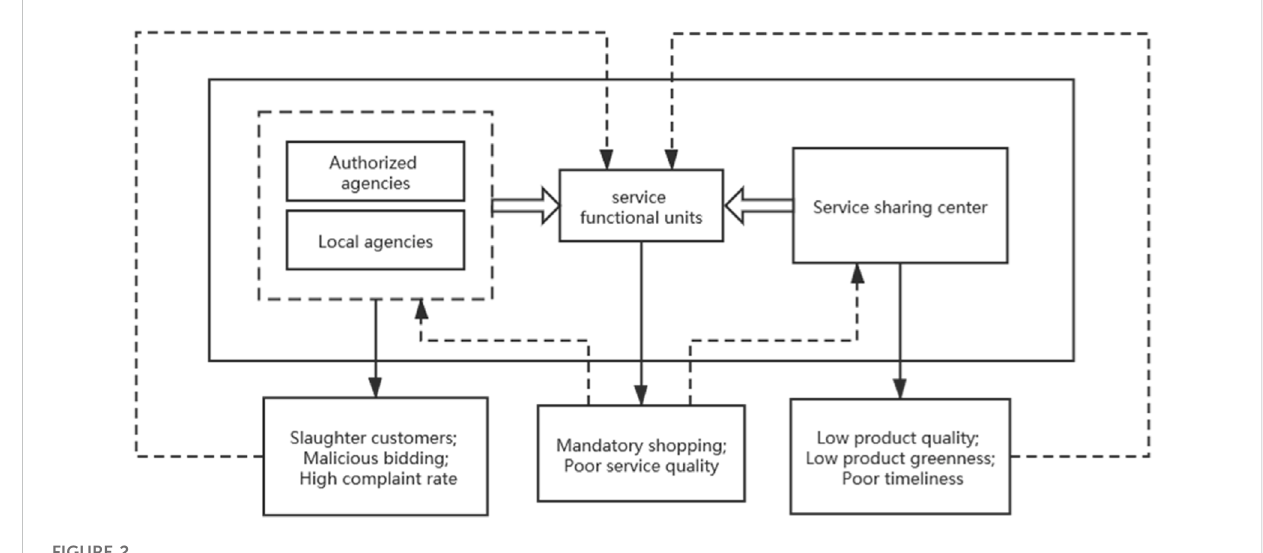
FIGURE 2 Membership of the tourism supply